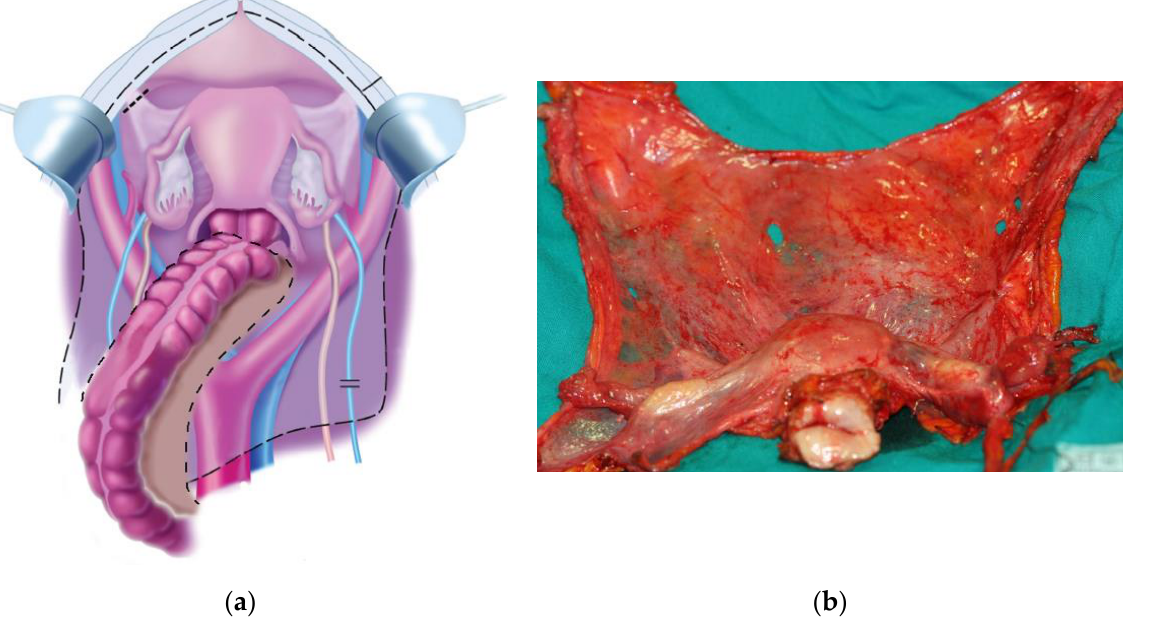
Figure 1. ( a ) Pelvic peritonectomy with en-bloc 7ysteron-adnexectomy. Dotted line represents the standard peritoneal resection margin after neoadjuvant chemotherapy with downstaging of perito- neal metastases; in most cases, no bowel resection is necessary to obtain a CCR-0 pelvic cytoreduc- tion. Reproduced from Sugarbaker P. H. (2013). Adapted with permission from AME Publishing Company (accessed on 6 May 2022). ( b ) Pelvic peritoneum removed en-bloc with uterus and ad- nexa. Note the “bat shape” aspect of the resected specimen [128].